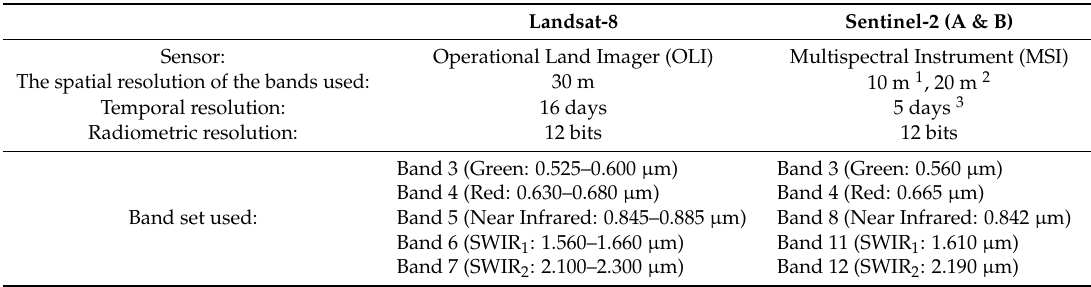
Table 1. Main characteristics of satellites and band set used by HidroMap. Landsat-8 Sentinel-2 (A & B) Sensor: Operational Land Imager (OLI) Multispectral Instrument